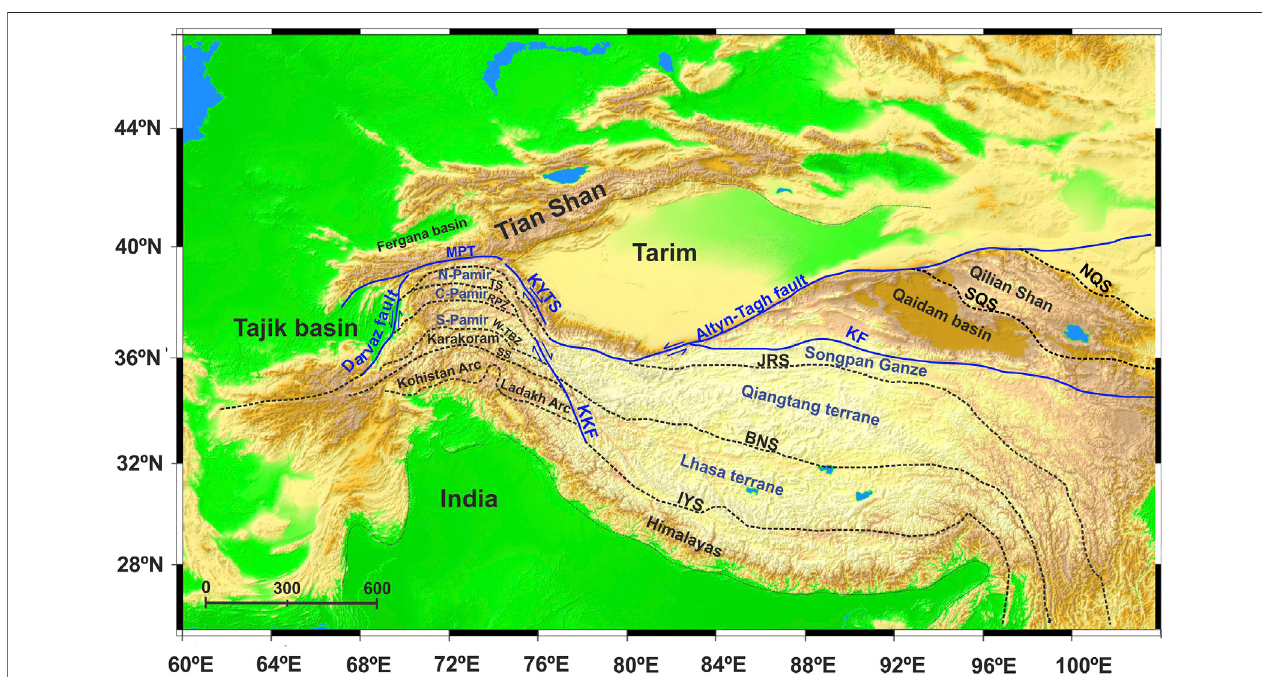
FIGURE 1 | A topographic map of the Pamir – Tibetan plateau and its surrounding regions. The blue colored terranes represent Gondwanan terranes that successivelyaccretedontotheEurasiaplate.Thedashedlineshighlightthemainsuturezones:TS,TanymasSuture;RPZ,Rushan-PshartZone;W-TBZ,Wakhan-Tirich Boundary Zone; SS, Shyok Suture; IYS, Indus Yarlung Suture; BNS, Bangong-Nujiang Suture; JRS, Jinsha River Suture; SQS, South Qialian Suture; NQF, North Qilian Fault. The blue lines highlight the major faults within the Pamir – Tibetan plateau, including KF, Kunlun Fault, KKF, Karakorum Fault; KYTS, Kashgar-Yecheng Transfer System; MPT, Main Pamir Thrust, and Darvaz